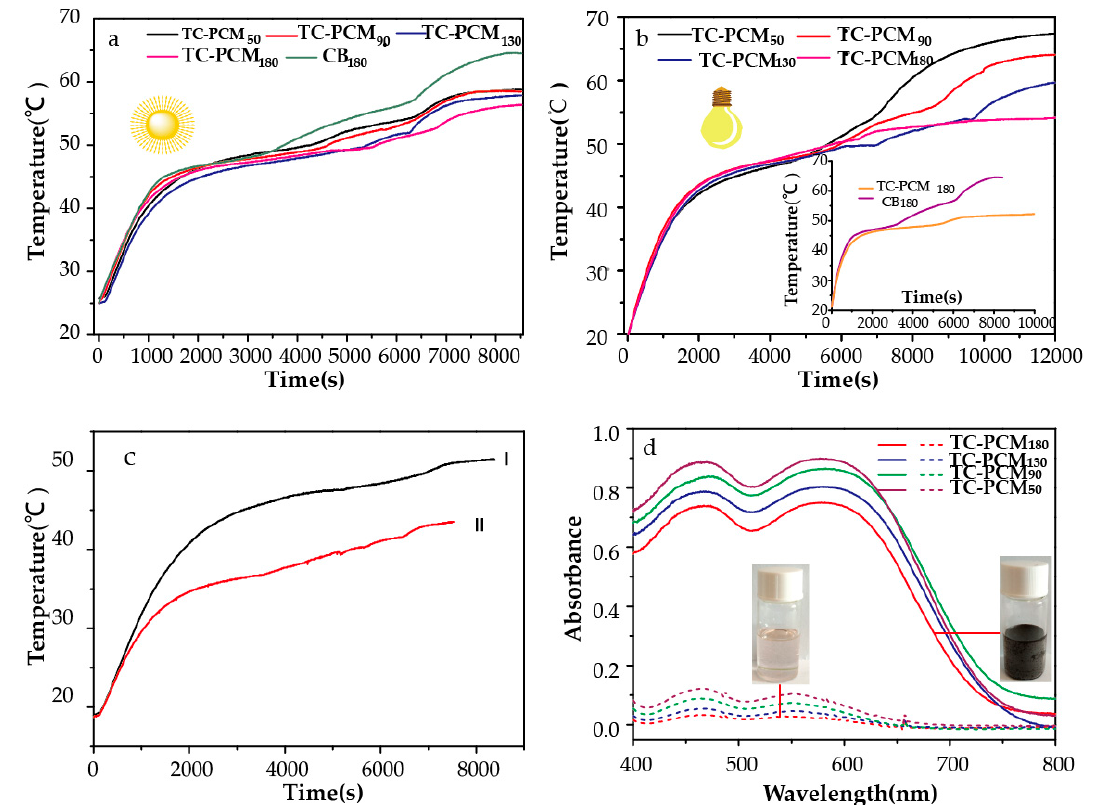
Figure 5. ( a ) Photo-thermal conversion curves under solar radiation ( b ) Photo-thermal conversion curves under simulative light ( c ) Photo-thermal conversion curves of 1-hexadecanol ( І ) and 1-tetradecanol ( Ⅱ ) as PCMs ( d ) visible light absorption of TC-PCMs under liquid and solid state.